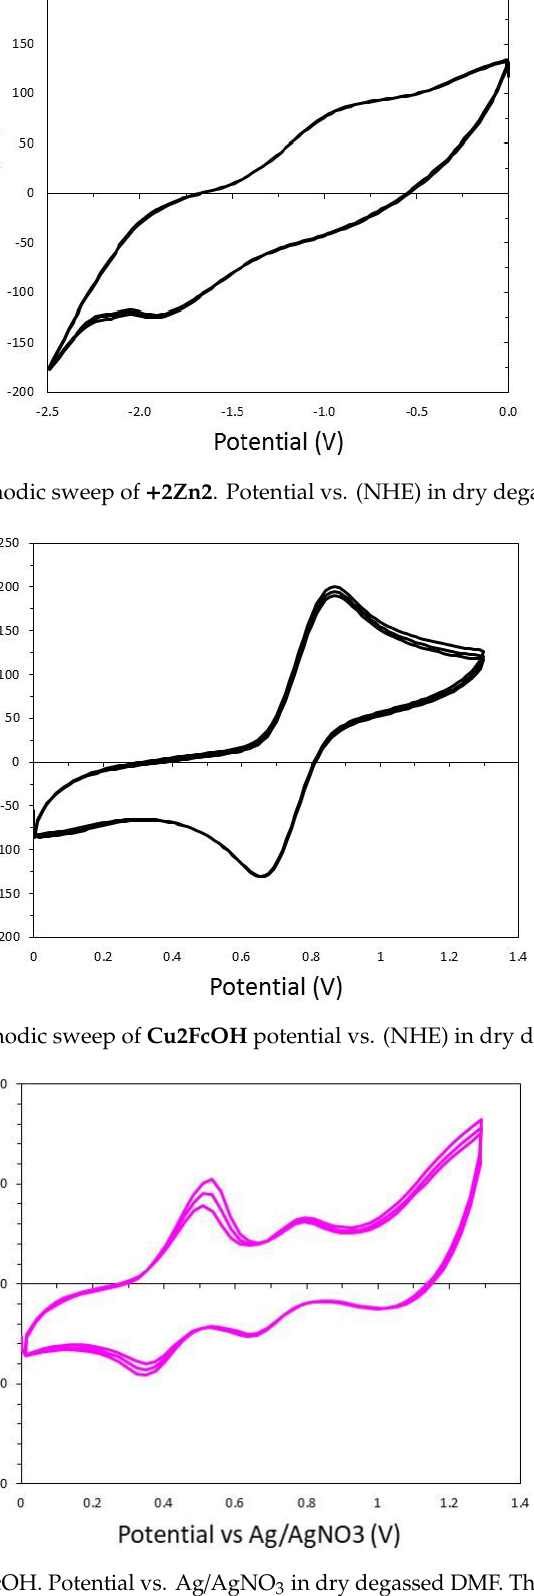
Figure 11. CV of + 2Cu2FcOH. Potential vs. Ag / AgNO 3 in dry degassed DMF. The first redox couple at Figure 11. CV of +2Cu2FcOH. Potential vs. Ag/AgNO 3 in dry degassed DMF. The first redox couple Figure 11. CV of +2Cu2FcOH. Potential vs. Ag/AgNO 3 in dry degassed DMF. The first redox couple E 0 = 0.429 V was identified as the copper metal center. The second redox couple at E 0 = 0.715 V is the at E 0 = 0.429 V was identified as the copper metal center. The second redox couple at E 0 = 0.715 V is at E 0 = 0.429 V was identified as the copper metal center. The second redox couple at E 0 = 0.715 V is Figure 11. CV of +2Cu2FcOH. Potential vs. Ag/AgNO 3 in dry degassed DMF. The first redox couple ferrocene the ferrocene ligands. the ferrocene ligands. at E 0 = 0.429 V was identified as the copper metal center. The second redox couple at E 0 = 0.715 V is the ferrocene ligands.